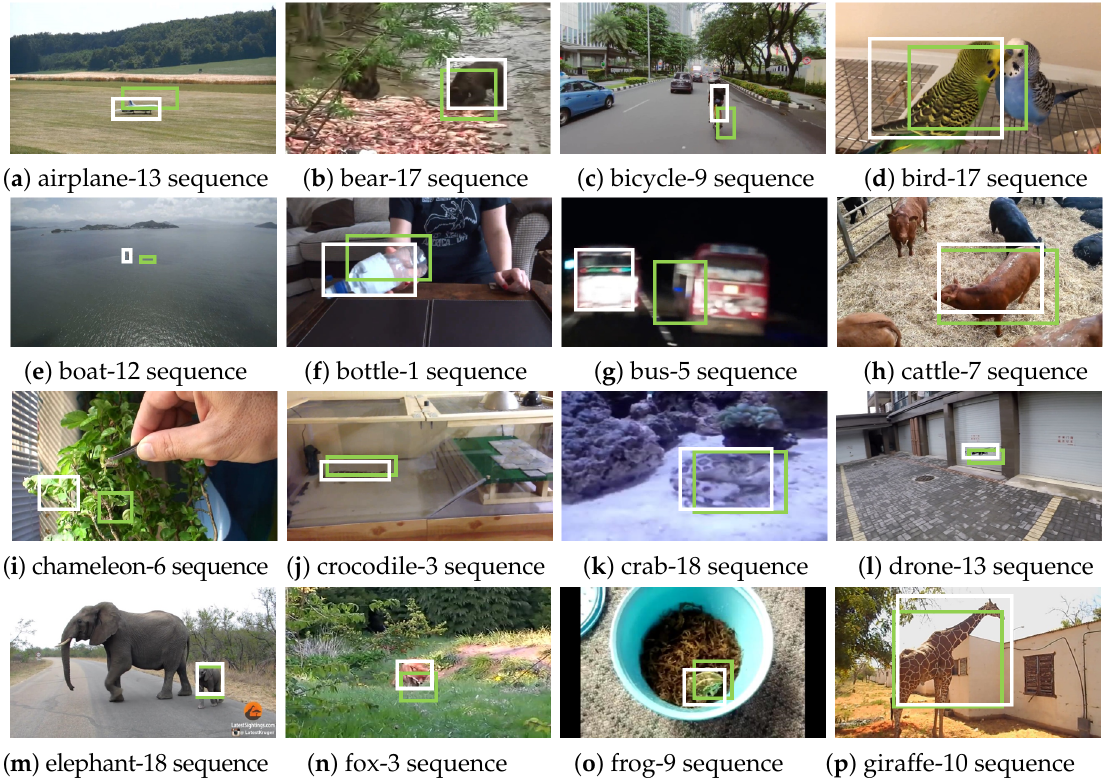
Figure 8. Qualitative evaluation. White and green boxes present the predicted bounding boxes of the proposed method with and without the Wang–Landau